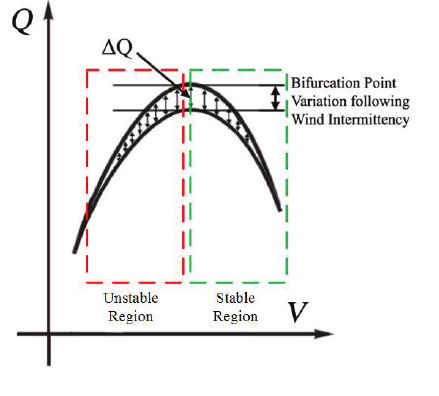
Figure 1. Voltage stability assessment in the presence of a wind power plant—adapted from